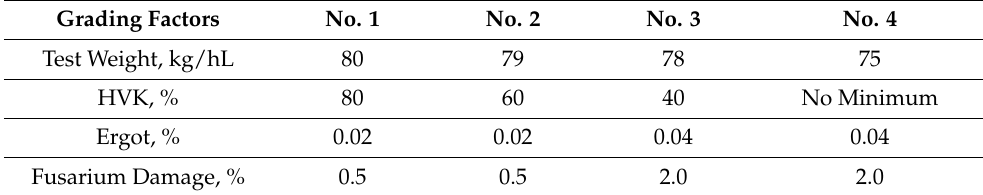
Table 2. Tolerances of selected grading factors for CWAD